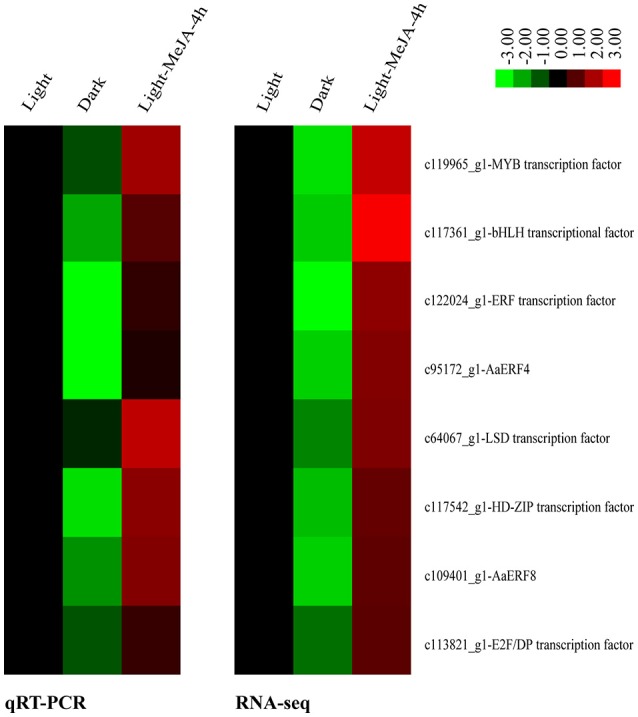
Relative heatmaps of qRT-PCR and RNA-sequencing (RNA-seq). Technical validation of 8 selected differentially expressed TFs detected by RNA-seq using qRT-PCR. Rows represent differentially expressed TFs, columns represent contrast groups. Green and red boxes represent TFs showing lower and higher expression level, respectively. Color saturation reflects magnitude of log2 expression ratio for each unigenes.